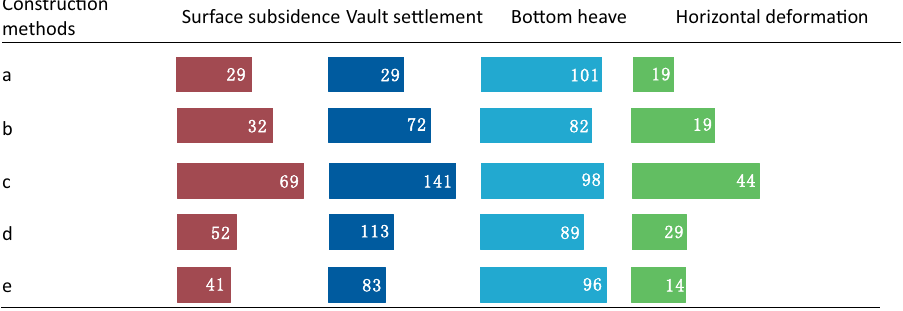
Table 12. Final displacement of surrounding rock at different construction methods (unit: